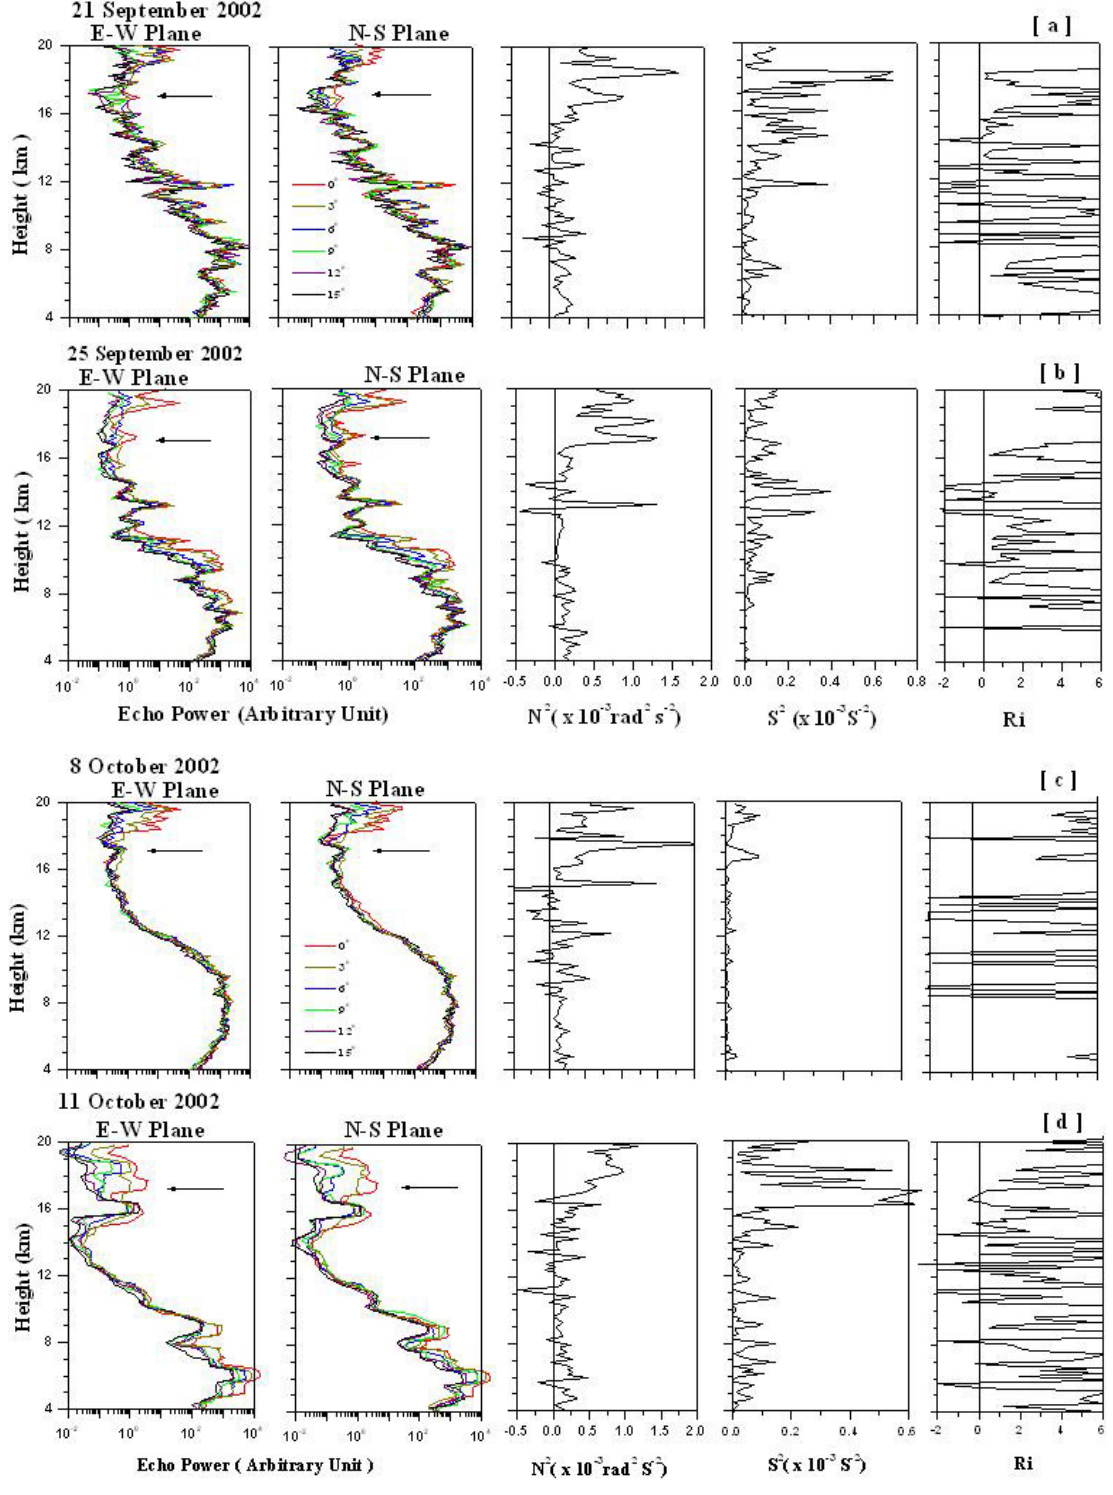
Fig. 2. Figures 2 ( a ) – ( d ) : Height profiles of radar echo power for different beam positions in E–W and N–S planes for (a) 21 September, (b) 25 September, (c) 8 October and (d) 11 October 2002. Height profiles of N 2 , square of vertical shear of horizontal winds (S 2 ) and Richardson number (R i ) are also plotted side by side. The horizontal arrow in each panel of power profiles represents the height of the tropical tropopause obtained GPS sonde